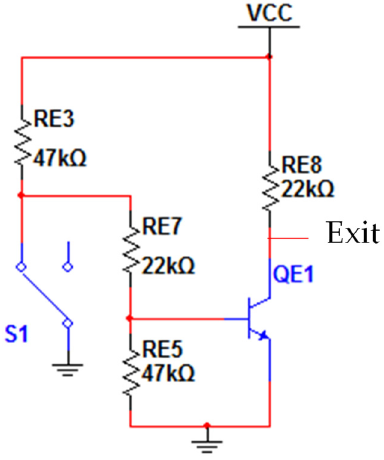
Figure 17. Circuit diagram of the waste bin sensor.